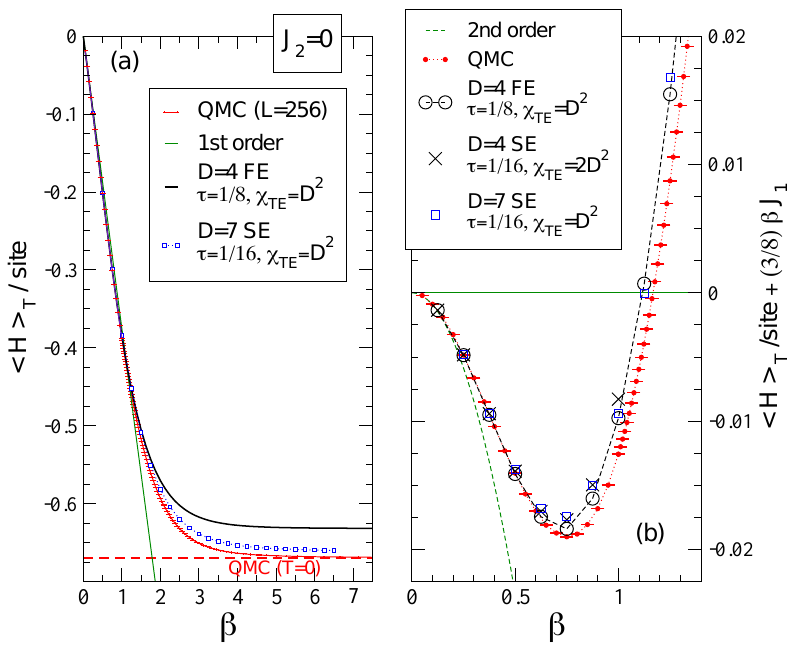
Figure 5: (a) Mean energy vs β = 1 / T computed using V = 1 ⊕ 0, D = 4 ( V = 1 ⊕ 0 ⊕ 1, D = 7), and FE (SE), and compared to QMC (on a cluster of size L = 256). The exact 1st order high-T behavior – linear in β (green line) – is subtracted in (b) to magnify the scale and compare different imaginary-time evolution dynamics (see text) to the second order high-T correction and to QMC. The finite-temperature QMC data are to be considered in the thermodynamic limit for β ≤ 4 (see text). The T = 0 QMC data are taken from Ref. [ 4 ]